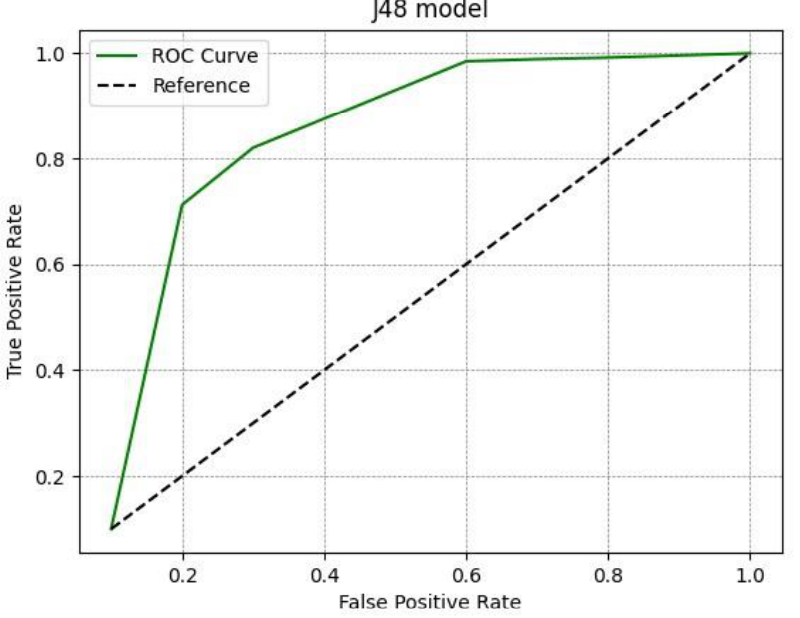
Figure 3. ROC curve for the Rep Tree model. Figure 3. — ROC curve for the Rep Tree model.